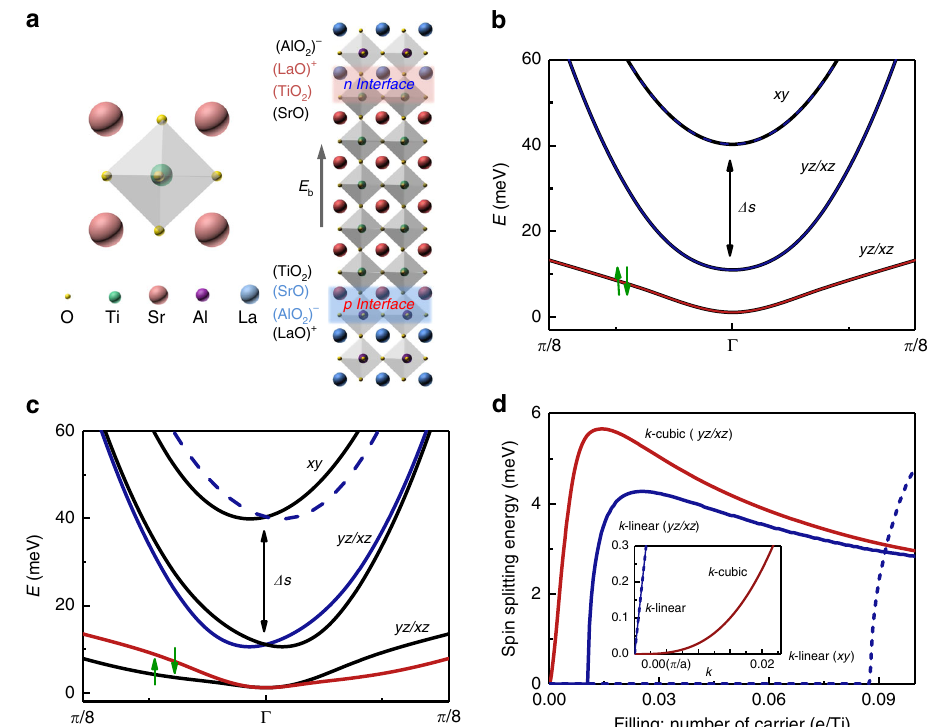
Fig. 1 Spin splitting in the LAO//STO/LAO heterostructure. a Schematic structure of STO (left) and the asymmetric LAO//STO/LAO heterostructure (right) with a large built-in electric fi eld E b . b Band structure of t 2g orbitals in the centrosymmetric STO layer. With compressive strain and spin – orbit interaction (SOI), the degenerate t 2g orbitals are lifted with a splitting energy Δ s . c Band structure of t 2g orbitals with inversion symmetry broken as in the LAO//STO/LAO heterostructure. The degeneracy of the d xy and d yz/xz orbital is further lifted by the SOI. d Spin splitting energy of the t 2g orbitals as a function of electron fi lling. The inset shows the k -linear and the cubic spin splitting of the corresponding